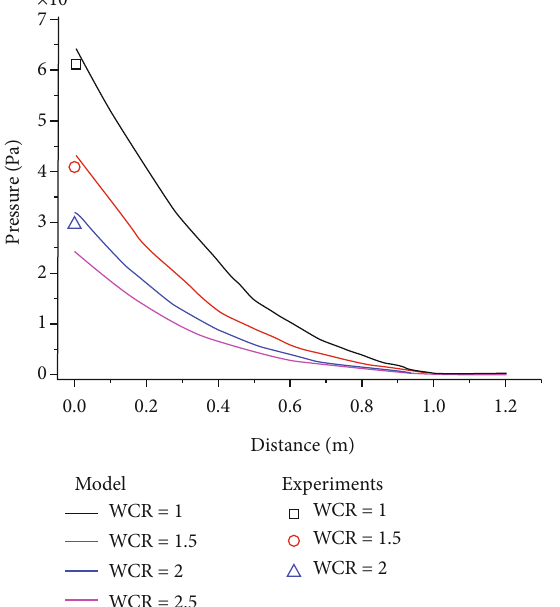
Figure 13: The variation of grout viscosity versus the di ff usion distance ( Q = 2 : 85 L/min , t = 60s